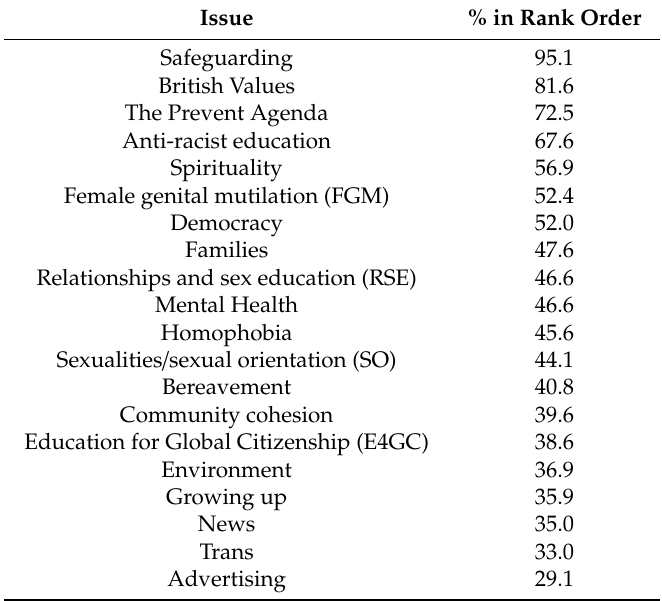
Table 3. Issues covered during students’ course of